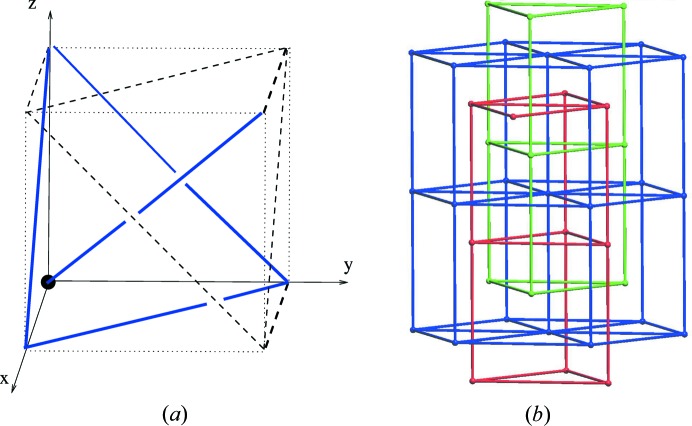
(a) A single-vertex quadruple-edged building block for the model net . (b) A (rescaled) fragment of this net. The diagonal edge in the building block gives a 32-penetrating edge.